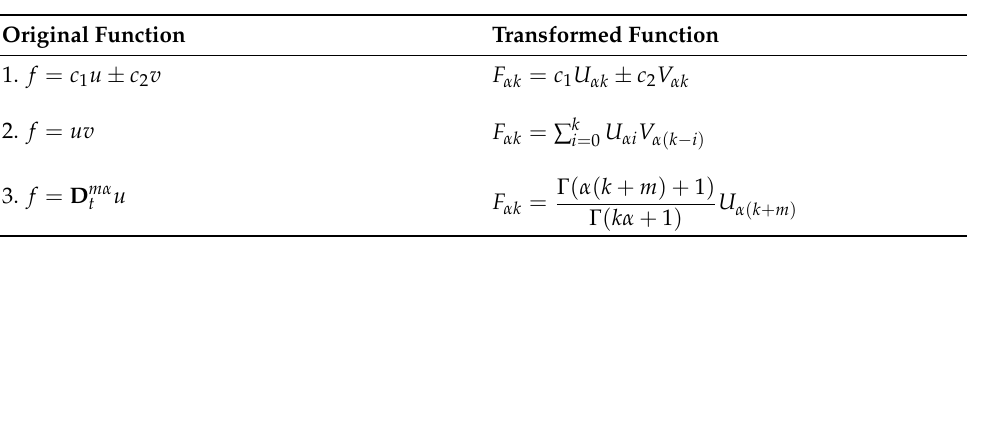
Table 1. Fundamental operations of the FRDTM for n + 1